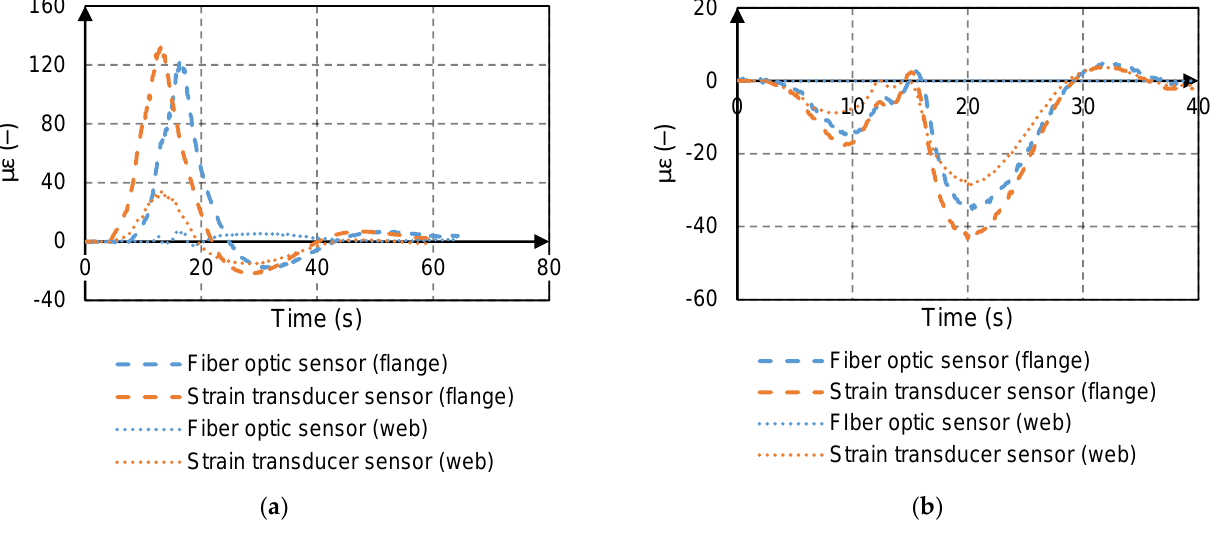
Figure 7. Strain histories: ( a ) positive moment location; ( b ) negative moment location.